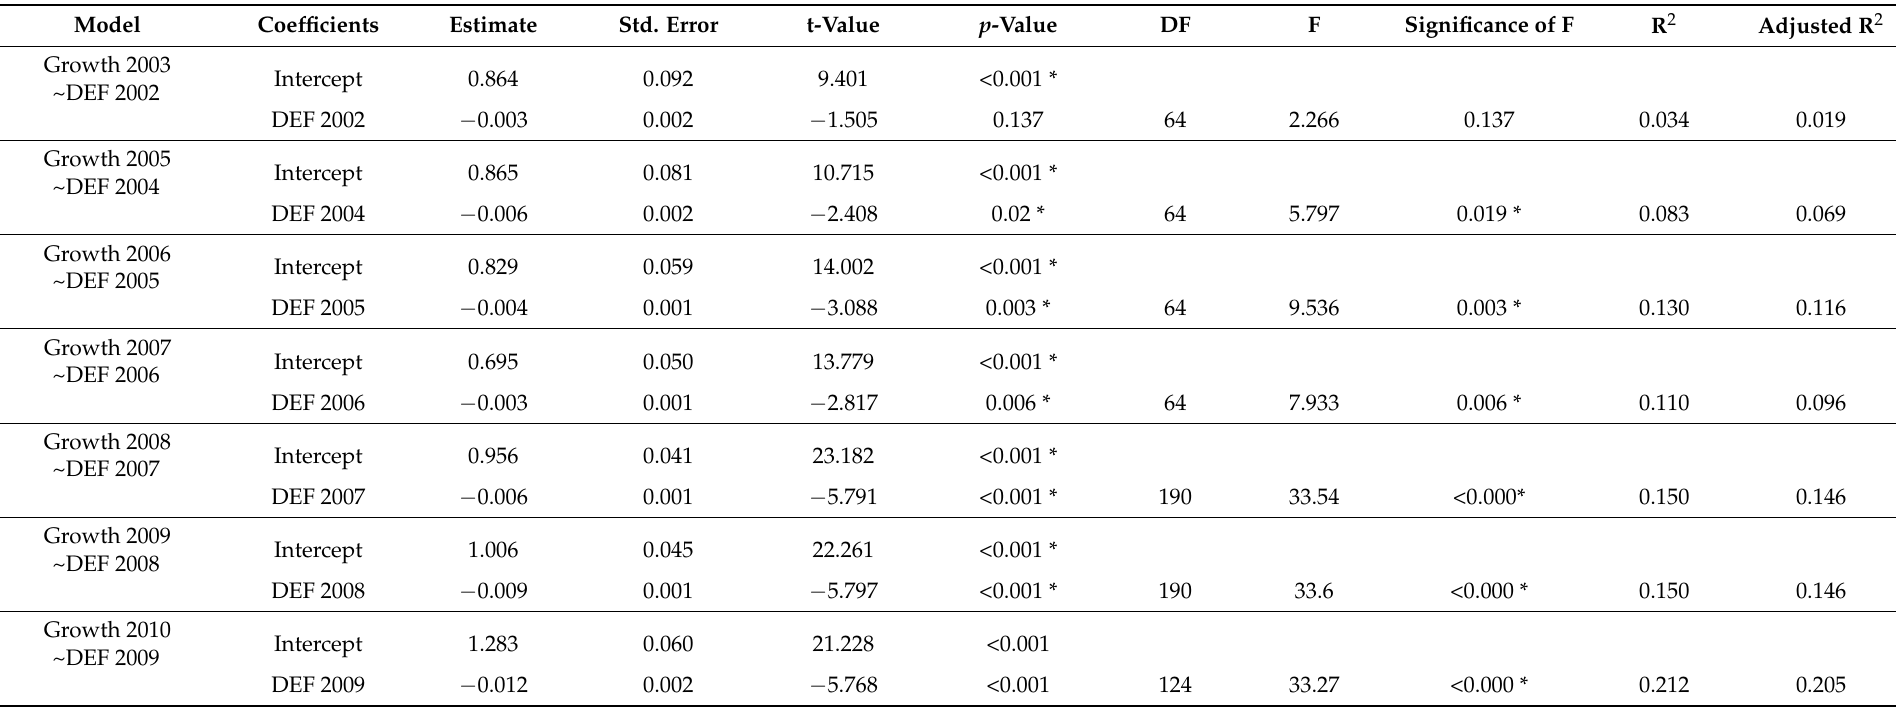
Table 2. Results of the linear regression between radial growth and defoliation, where radial growth is the dependent variable and defoliation is the explanatory variable. Growth in millimetres, DEF = defoliation in percentages, Std. Error = standard error, DF = degrees of freedom. p -value with <0.05 indicates statistically significant difference (marked